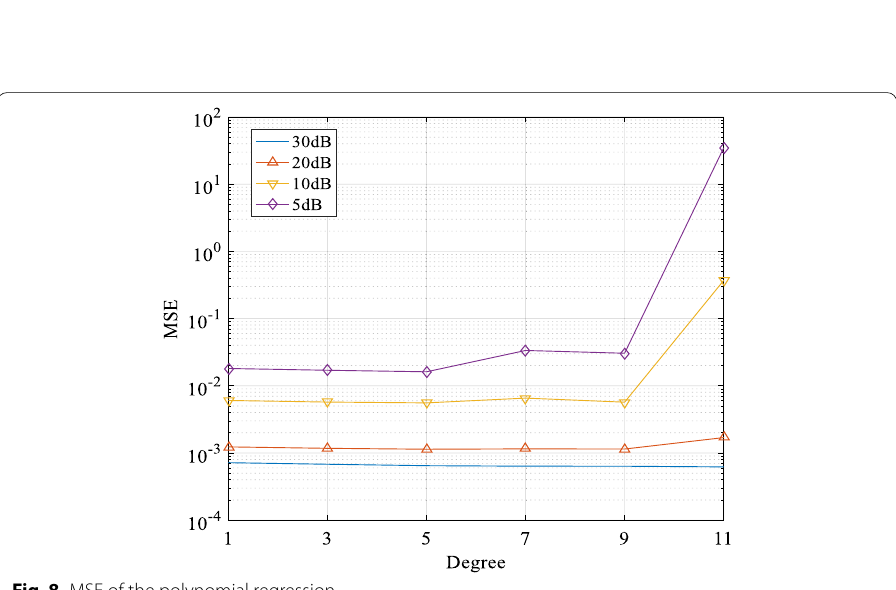
Fig. 8 MSE of the polynomial